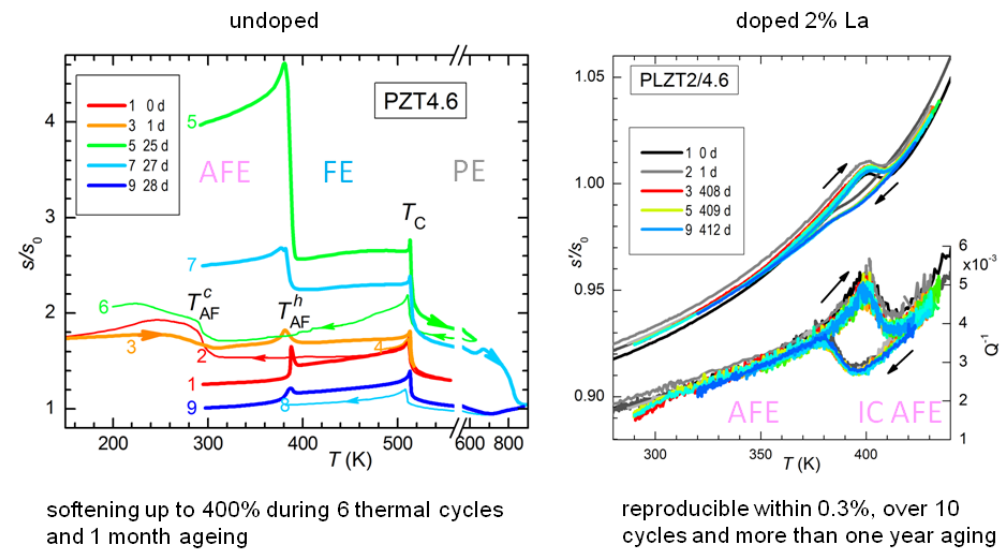
Figure 11. Effect of thermal cycles with AFE/FE transitions, ageing and recovery after high temperature anneal on PZT4.6. By doping with 2% La the FE phase becomes IC AFE and the material becomes perfectly stable under thermal cycles and aging. Adapted with permission from Ref. [47], copyrighted by the American Institute of